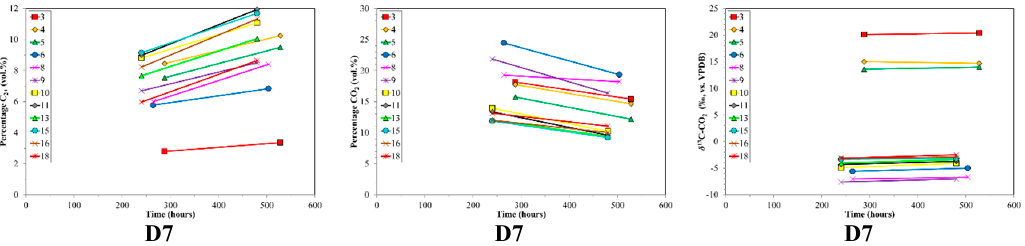
Figure 4. Time series of volume % C 2+ , volume % CO 2 and δ 13 C-CO 2 for desorption samples sets (top to bottom) versus production time. Sample set D5 was not plotted due to insufficient data. Note the different scales between sample sets.